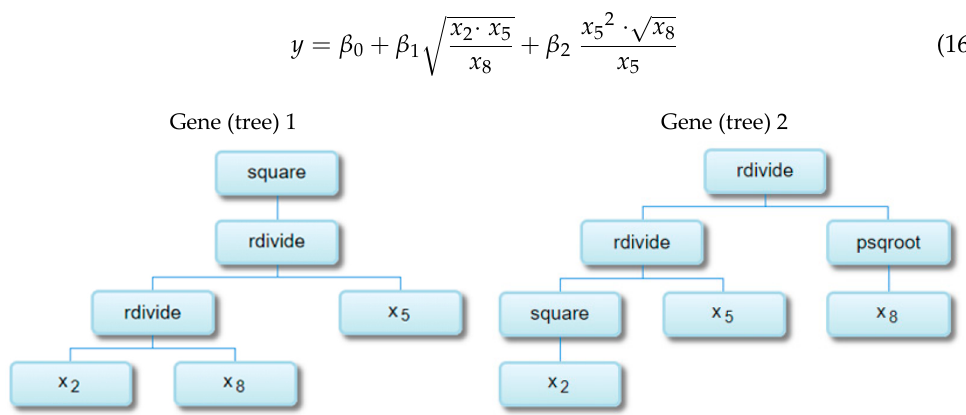
Figure 5. Typical 2-gene program evolved by MGGP with a maximum tree depth of 4.